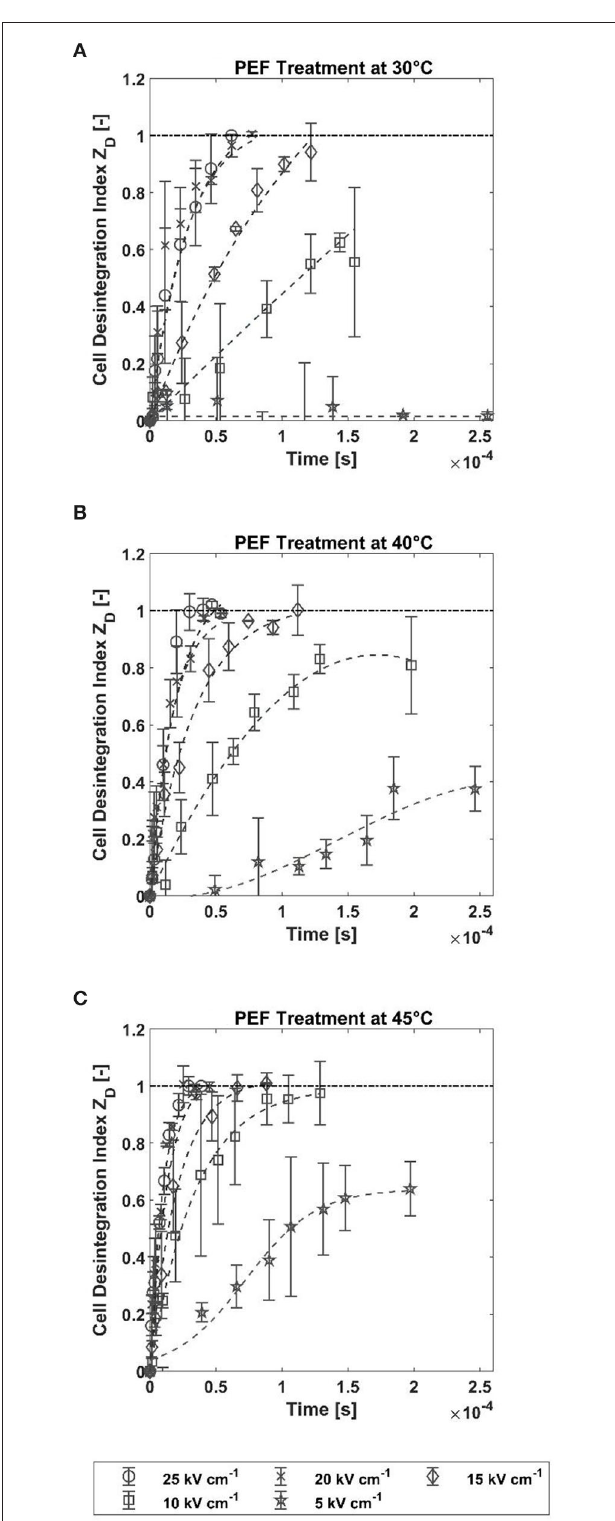
FIGURE 2 | Cell disintegration index Z D vs. treatment time at five different field strengths and treatment temperatures of 30, 40, and 45 ◦ C. The error bars